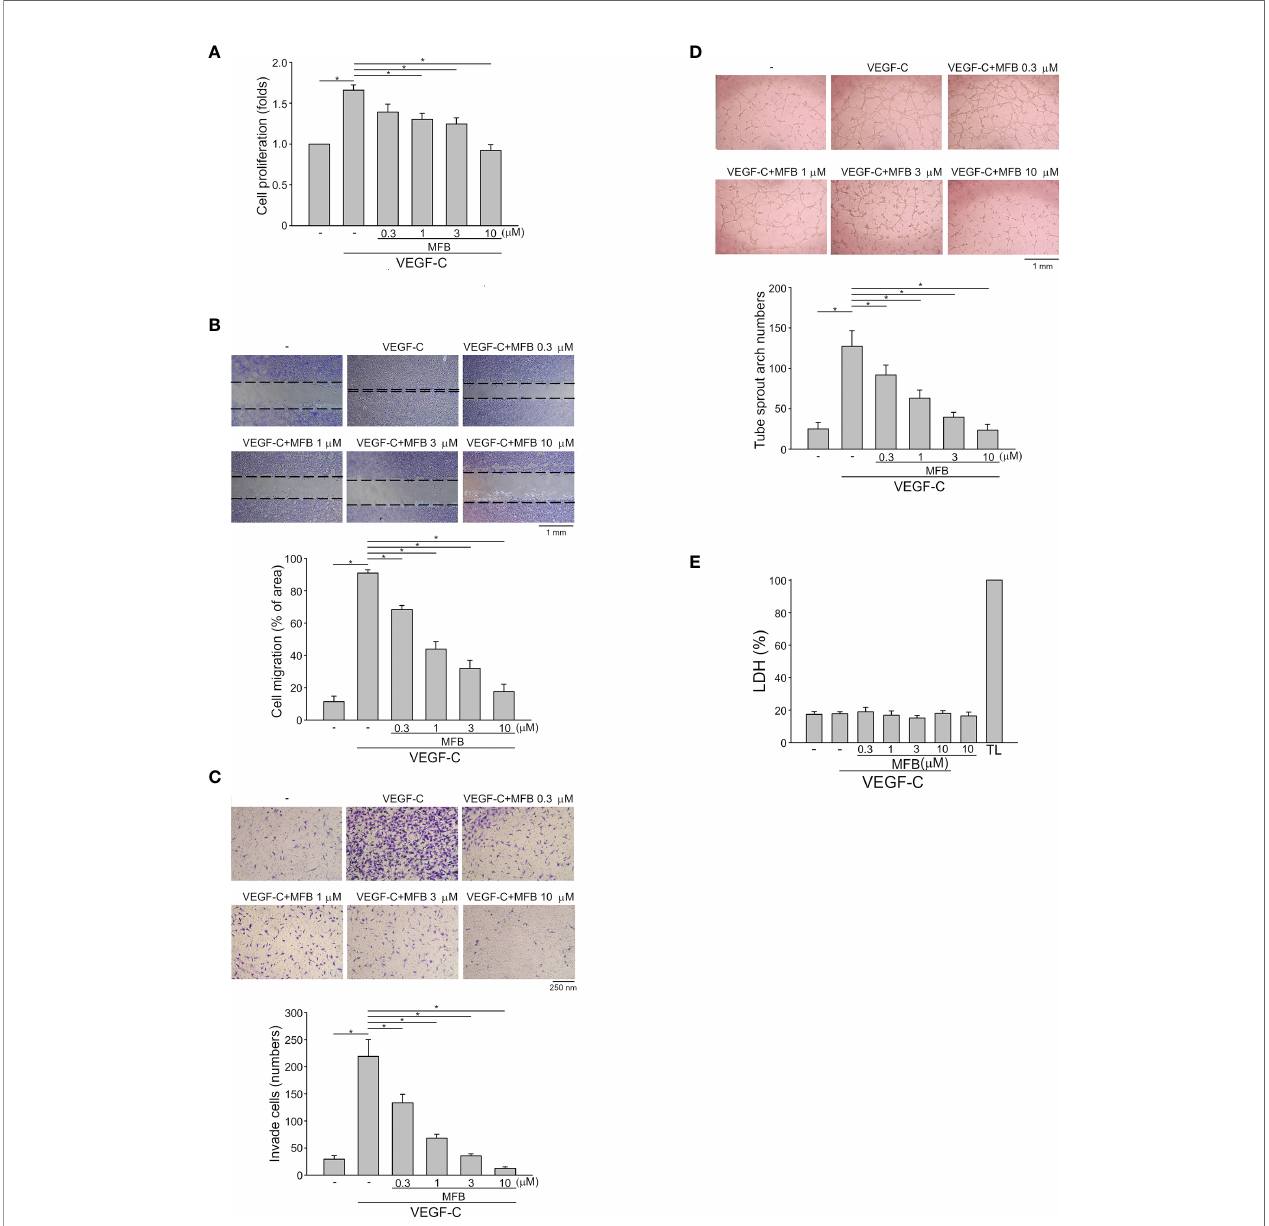
FIGURE 2 | MFB suppressed VEGF-C-induced cell migration, invasion, and tube formation of SV-LECs (A) SV-LECs were starved in serum-free DMEM for 18 h. After starvation, cells were treated with MFB, followed by the stimulation with VEGF-C (100 ng/ml) for another 24 h. Cell proliferation was determined by a BrdU-based cell proliferation assay. Each column represents the mean ± S.E.M. of six independent experiments performed in duplicate. Technical replicates were used to ensure the reliability of singe values for each experiment. *P <.05, signi fi cantly different from VEGF ‐ A alone; Kruskal – Wallis test. (B) After starvation as described in (A) , cells were scratched and treated with vehicle or MFB in the absence or presence of VEGF-C for another 24 h. The rate of cell migration was determined. Each column represents the mean ± S.E.M. of six independent experiments * P <.05, signi fi cantly different from VEGF ‐ A alone; one ‐ way ANOVA, with Tukey ’ s post ‐ hoc test. (C) After starvation as described in (A) , a total of 2 x 10 4 SV-LECs were seeded in the top gelatin-coated chamber and treated with vehicle or MFB using VEGF-C as a chemo-attractant. After 18 h, the SV-LECs that invaded through the gelatin-coated membrane barrier were stained and quanti fi ed. Each column represents the mean ± S.E.M. of ten independent experiments *P <.05, signi fi cantly different from VEGF ‐ A alone; one ‐ way ANOVA, with Tukey ’ s post ‐ hoc test. (D) SV-LECs were seeded on Matrigel in the presence of VEGF-C (100 ng/ml) with or without MFB. Cells were photographed under phase-contrast after 3 h. Bar graphs show compiled data of average sprout arch numbers (n = 6). *P <.05, signi fi cantly different from VEGF ‐ A alone; one ‐ way ANOVA, with Tukey ’ s post ‐ hoc test. (E) SV-LECs were stimulated with VEGF-C (100 ng/ml) with or without MFB for 18 h. An LDH assay was used to determine the cytotoxicity of MFB. Cells were also treated with cell lysis buffer (total lysis, TL) to serve as a positive control (100%). Each column represents the mean ± S.E.M. of six independent experiments performed in duplicate. Technical replicates were used to ensure the reliability of single values for each experiment. *P <.05, signi fi cantly different from VEGF ‐ A alone; Kruskal – Wallis